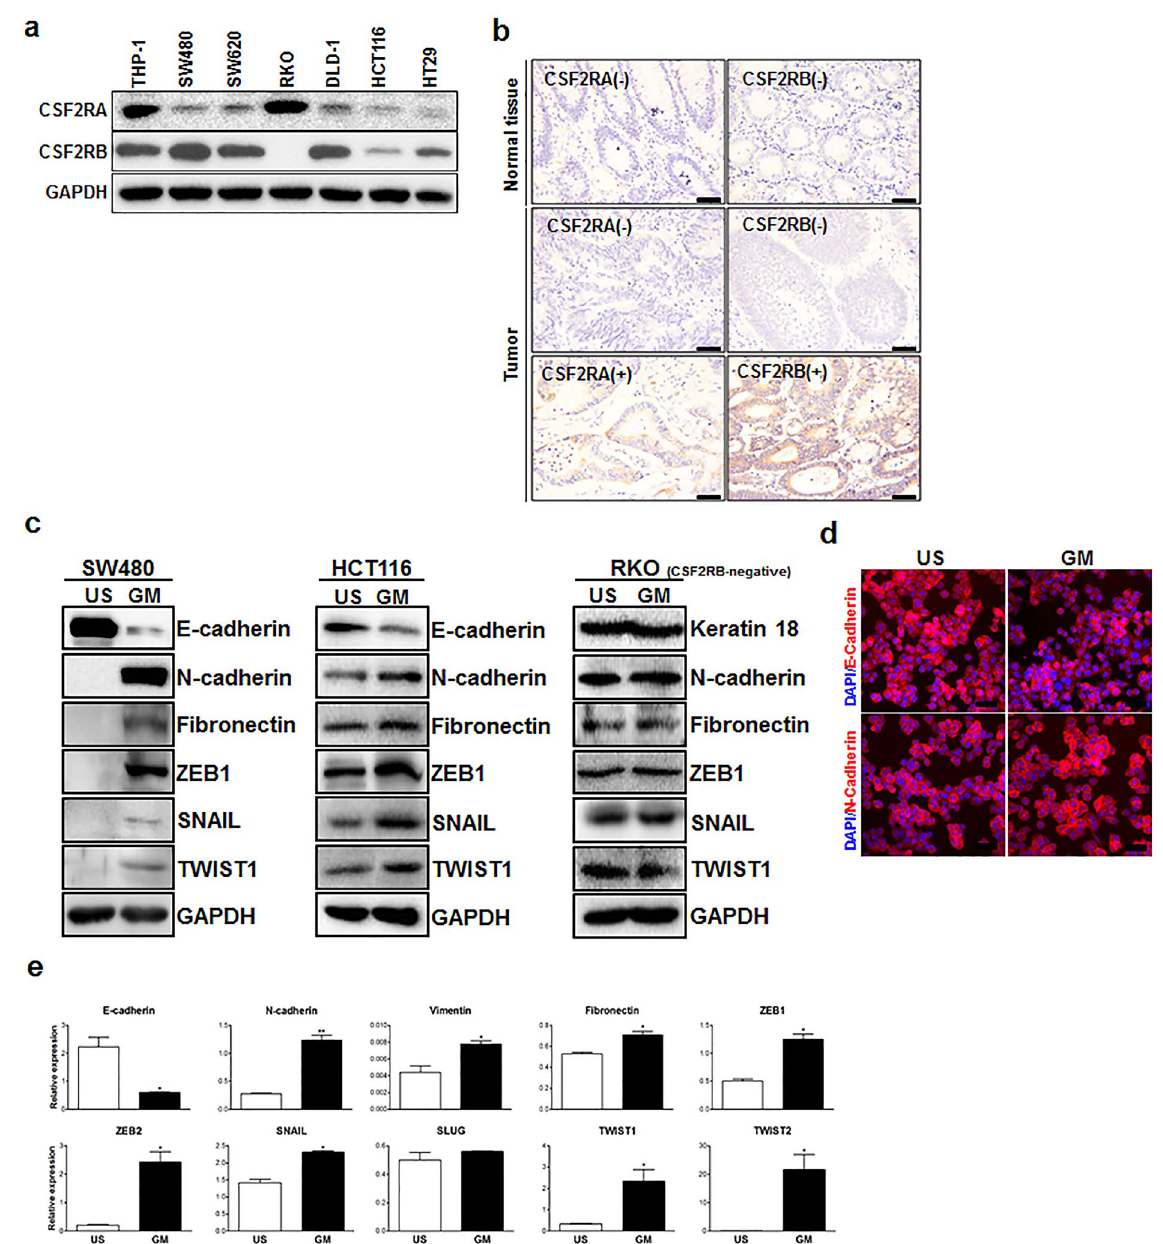
Figure 1. Chronic stimulation of colon cancer cells with GM-CSF leads to EMT. ( a ) The subunit α and β of GM-CSF receptor in six colon cancer cell lines were examined by Western blotting. A human monocytic cell line THP-1 was used as a positive control. ( b ) GM-CSF receptor was detected by IHC in specimen (tumor and adjacent normal colon tissues) of CRC patients. Representative data were shown. Scale bar: 50 μ m. ( c ) Three colon cancer cell lines (SW480, HCT116 and RKO) were stimulated with GM-CSF (25 ng/ml) for three weeks. The expression of epithelial and mesenchymal markers as well as EMT-related transcriptional factors indicated was examined by immunoblotting. Representative data of cropped blots from five independent experiments were shown. ( d ) The expression of E-cadherin and N-cadherin in SW480 cell line treated with GM-CSF as described above was detected by immunofluorescence. Representative images from three independent experiments were shown. Scale bar: 100 μ m. ( e ) SW480 cell line was treated with GM-CSF as described above. The expression of EMT-related markers and transcriptional factors was examined by quantitative RT-PCR. The data were pooled from three experiments. US: unstimulated; GM: GM-CSF. * P < 0.05; ** P < 0.01 vs untreated